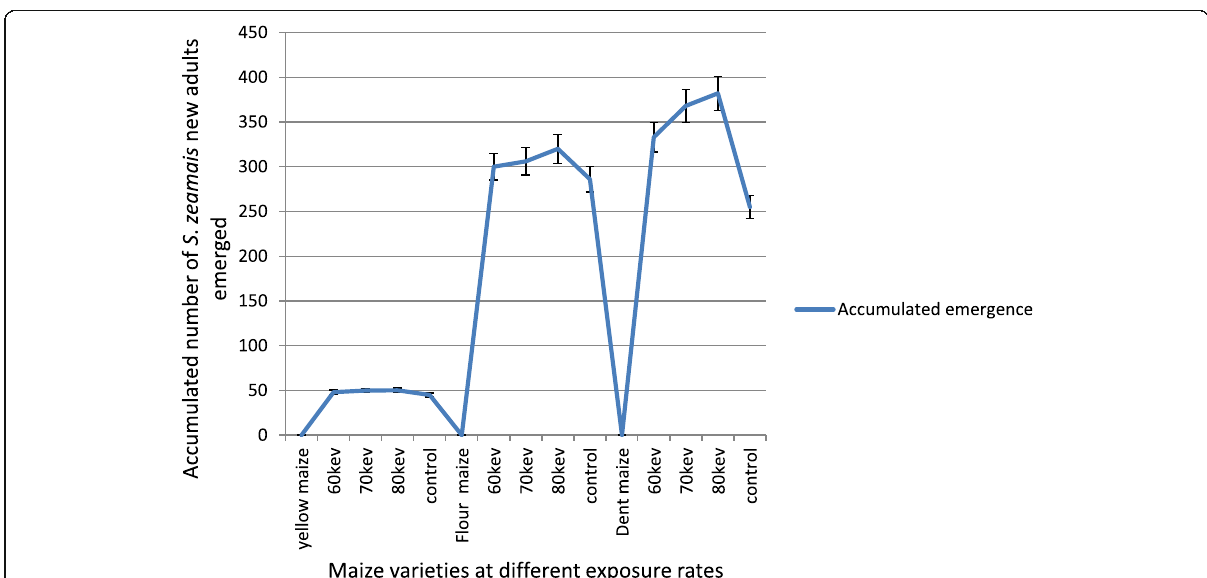
Fig. 4 Effect of X-ray exposure dose (KeV) on accumulated emergence of new Sitophilus zeamais Motschulsky adults from three varieties of